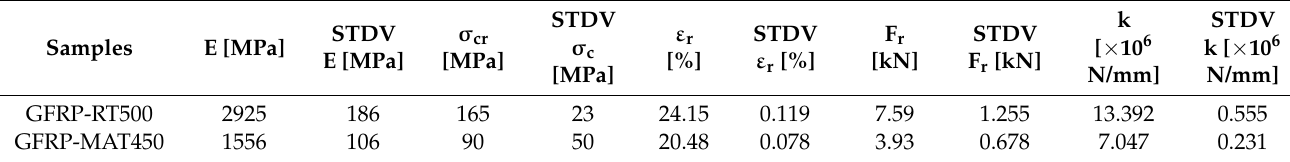
Figure 4. The stress–strain curves in case of compression tests for two types of GFRP samples. Table 5. Average values of elastic characteristics obtained after the compression test. Legend: E—elasticity modulus; σ c —compression strength; ε r —percentage strain at break; F r —load at break;